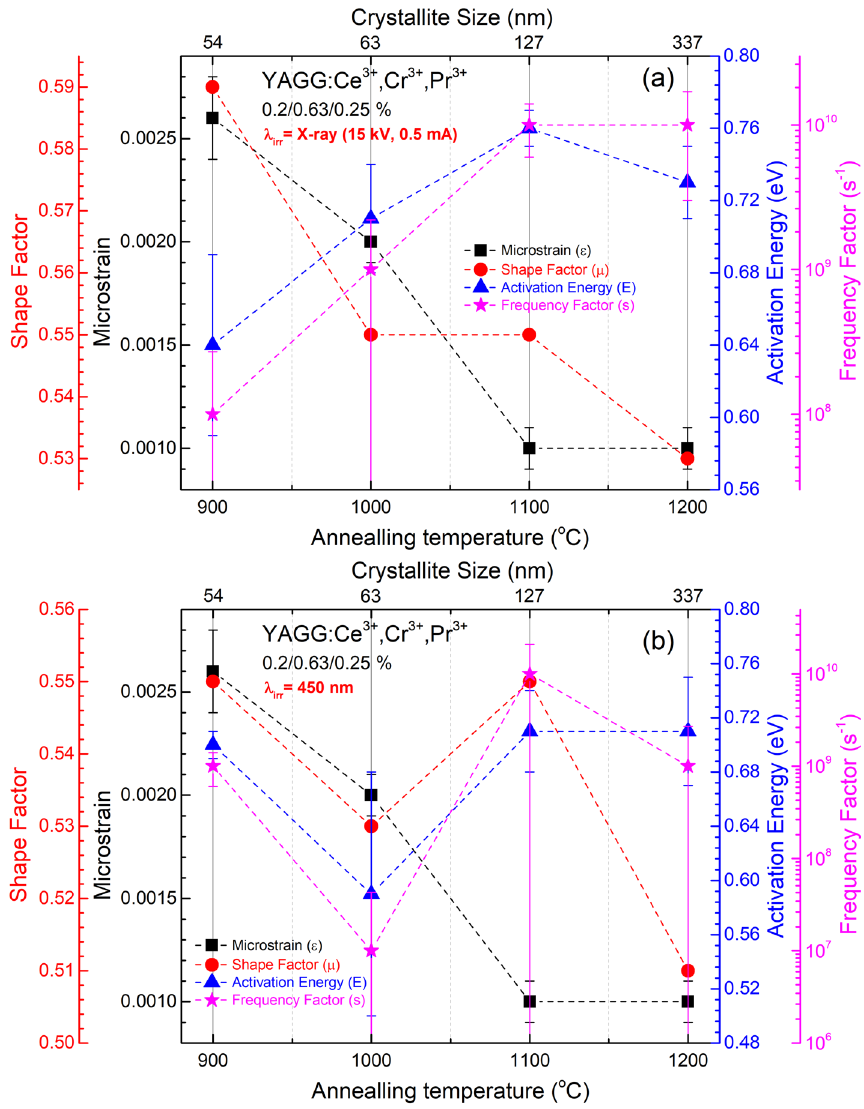
Figure 10. Correlation between microstrain and TL parameters (shape factor, activation energy, and frequency factor) for the X-ray ( a ) and blue-light ( b ) irradiation as a function of the crystallite size (annealing